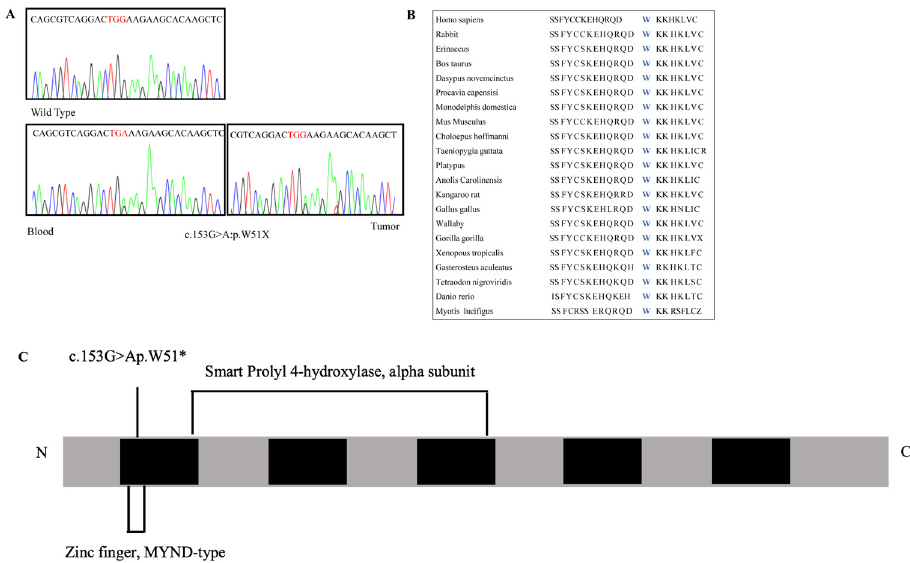
Figure 4. Genetic analysis. ( A ): Wild-type and mutated electropherogram showing the variant c.153G>A, p.W51* variant in exon 1 of the EGLN1 gene in both blood and tumor samples. ( B ): Amino acid conservation among the species. ( C ): Scheme of ENGL1 gene. Five boxes indicate the ENGL1 exons (black).